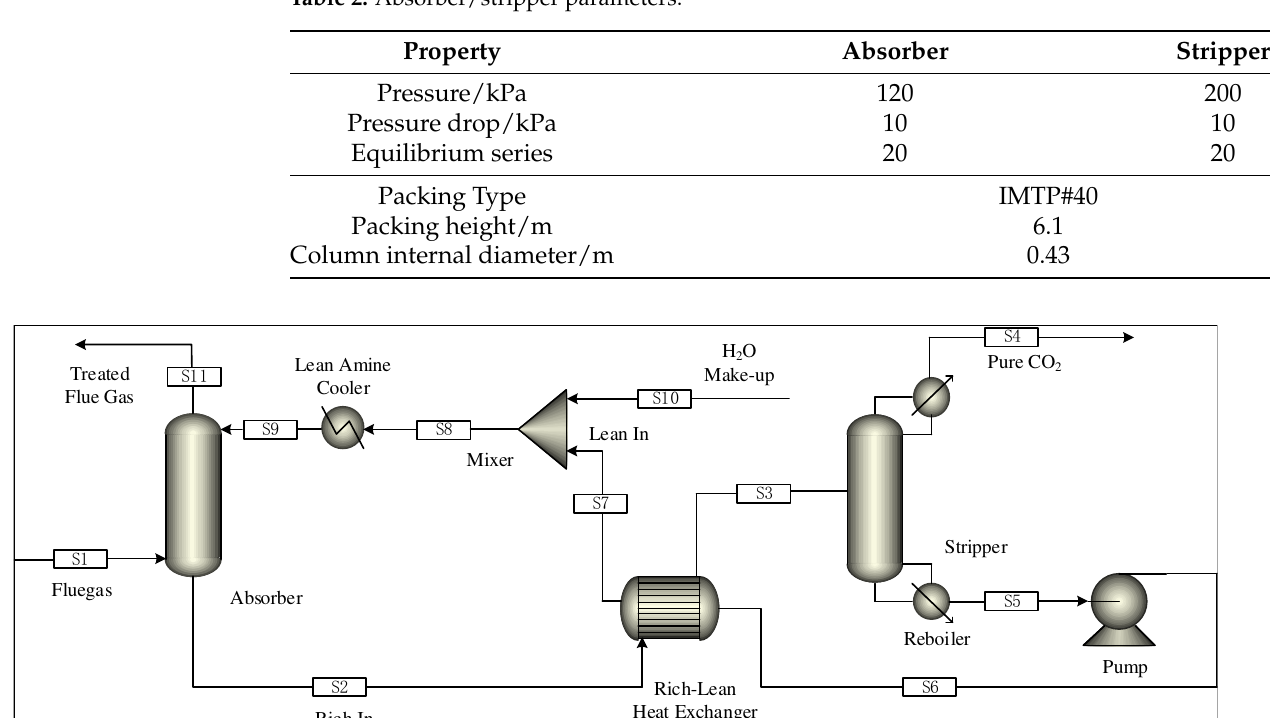
Table 2. Absorber/stripper parameters.